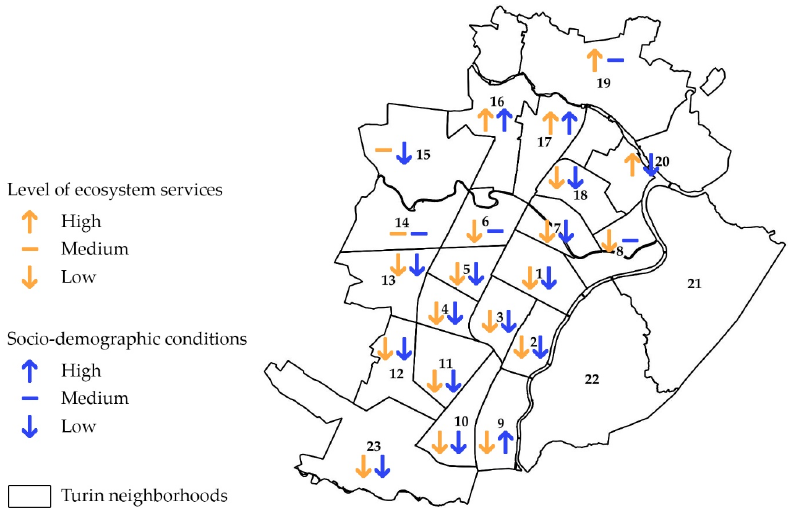
Figure 7. Qualitative evaluation (high, medium, low) map of Turin neighborhoods, according to ecosystem services levels and socio-demographic conditions. For neighborhoods 21 and 22 data are not available.